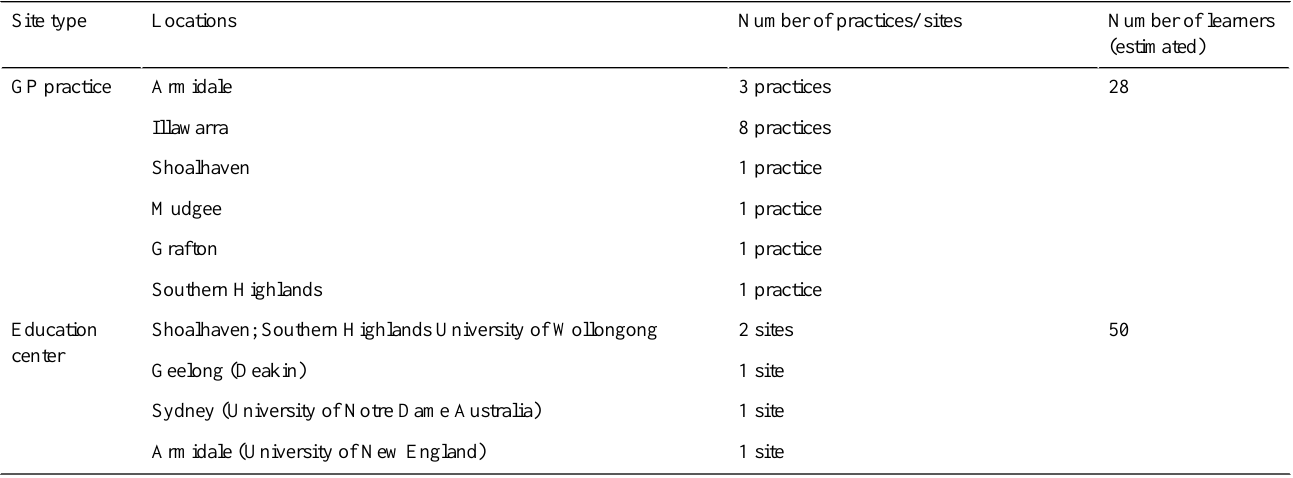
Table 1. Proposed sites and learners for virtual clinic participation.